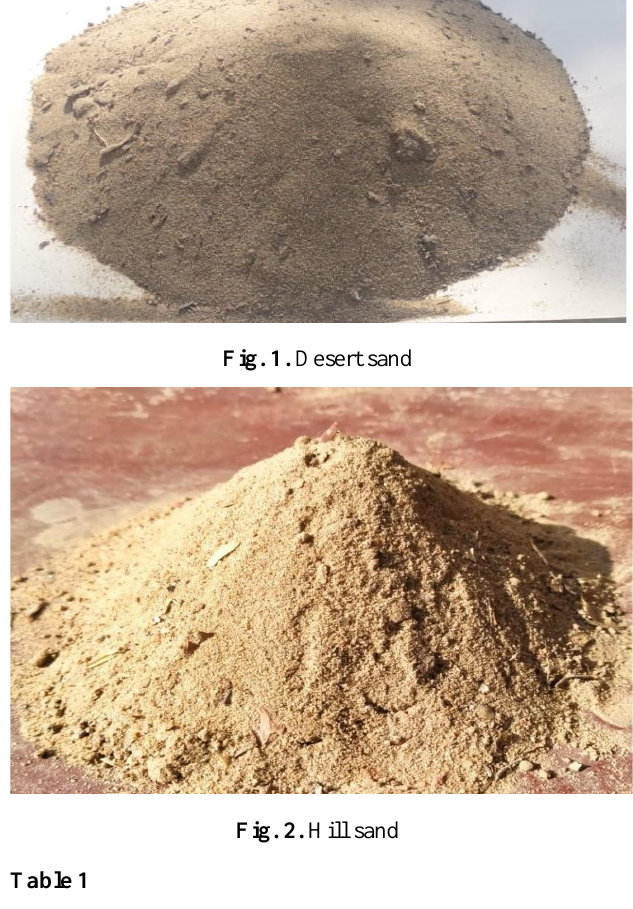
Fig. 2. Hill sand